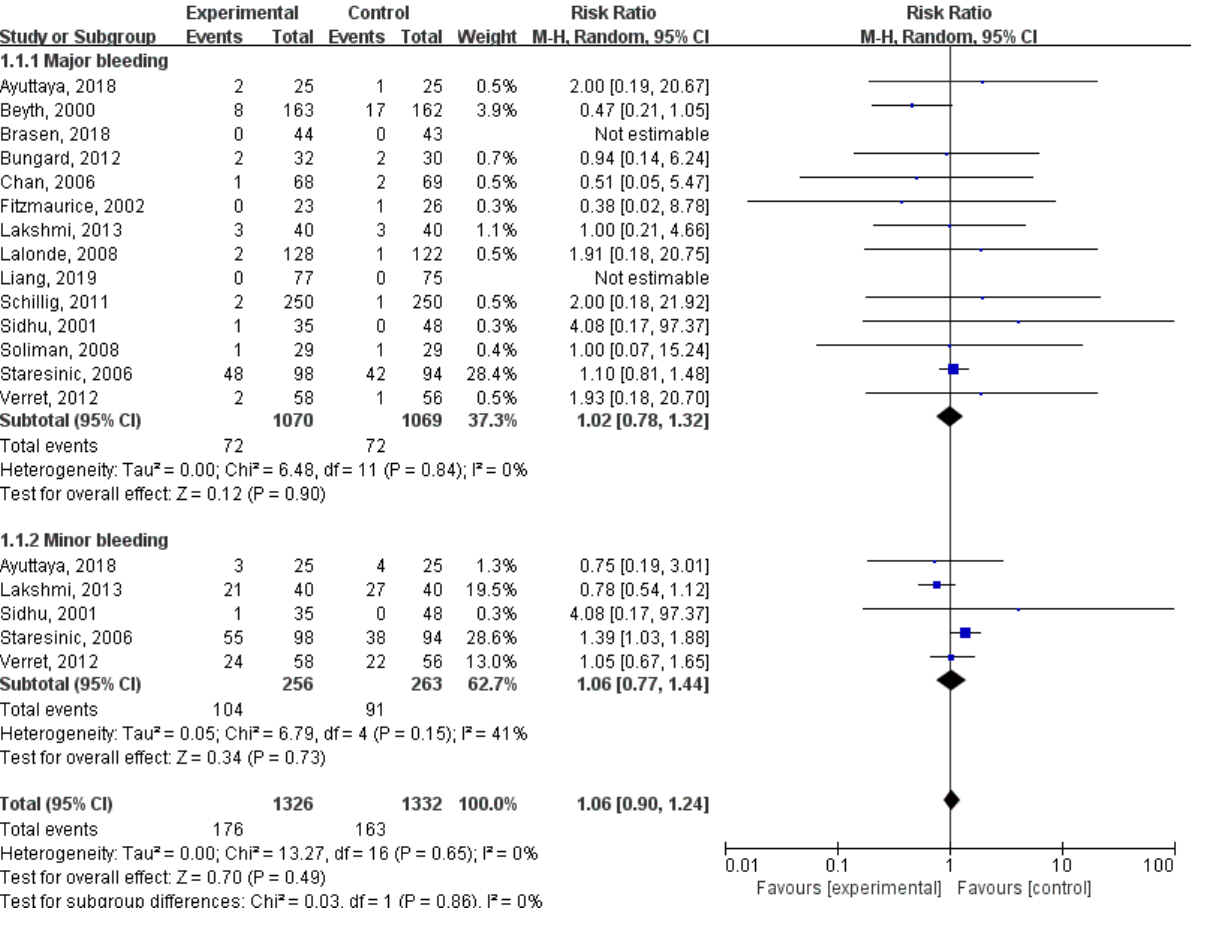
Figure 4. Results of a meta-analysis of the effects of technology-based interventions on major bleeding and minor bleeding events in oral anticoagulation management. M-H: Mantel-Haenszel method. Random: random effect